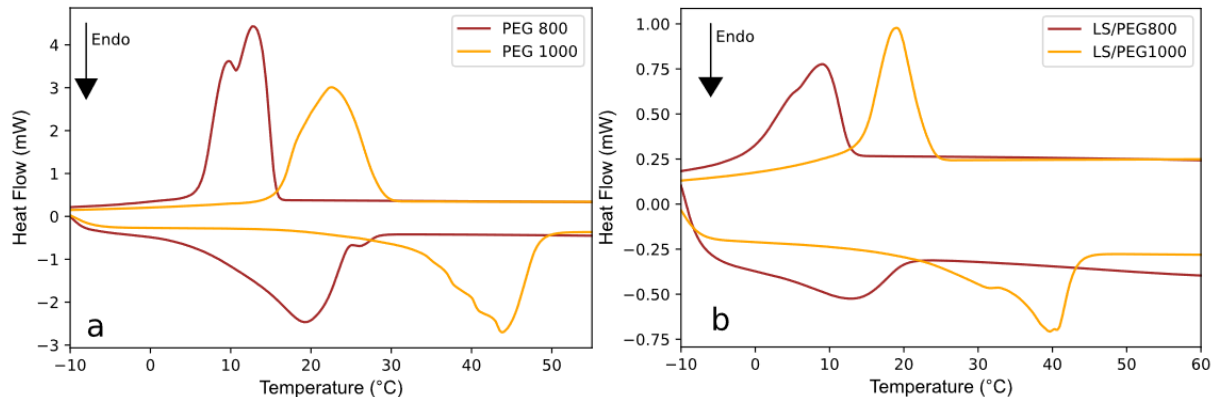
Figure 1. DSC curves of: ( a ) PEG 800 and PEG 1000 polymers; ( b ) LS/PEG 800 PCM and LS/PEG 1000 PCMs. Reproduced with permission from Sarcinella A. et al., Physical Properties of an Eco- Sustainable, Form-Stable Phase Change Material Included in Aerial-Lime-Based Mortar Intended for Different Climates, published in Materials , 2022